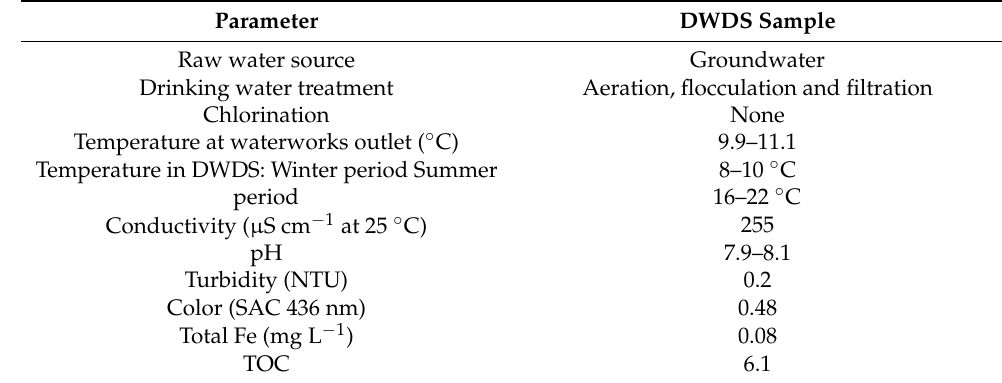
Table 1. The characteristics of the drinking water from the studied network in Northern Germany, which was populated with Paratanytarsus grimmii .